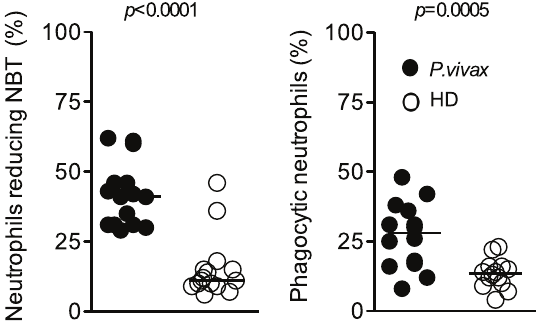
Figure 4. Neutrophils from P.vivax -infected patients produce high levels of superoxide and display enhanced phagocytic function. Neutrophils were isolated from P. vivax -infected patients (closed circles; n=15) or healthy donors (open circles; n=15), and the frequencies of neutrophils reducing NBT (left panel) as well as cell containing zymosan (right panel) were quantified. Significant differenc- es are indicated with p -values using unpaired t test or Mann-Whitney test when a normality test failed.